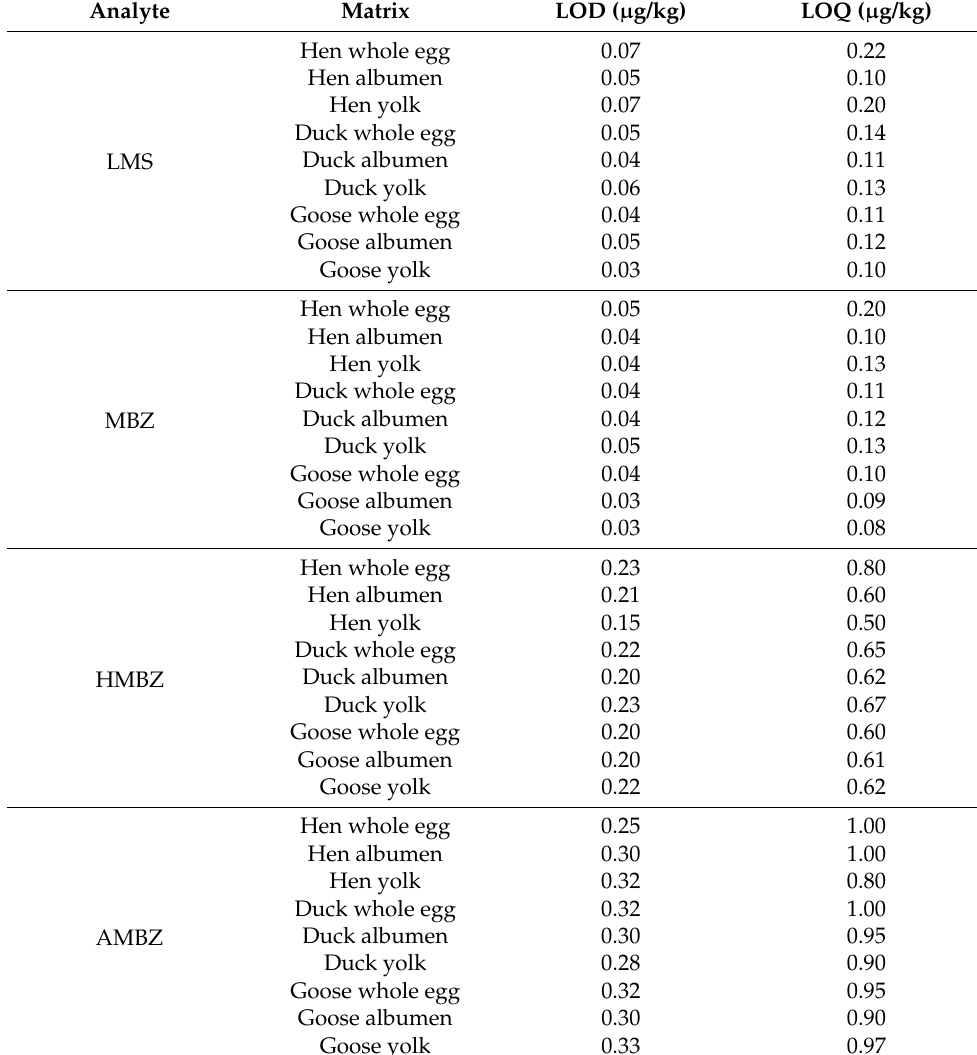
Table 8. LODs and LOQs for LMS, MBZ, HMBZ, and AMBZ in poultry